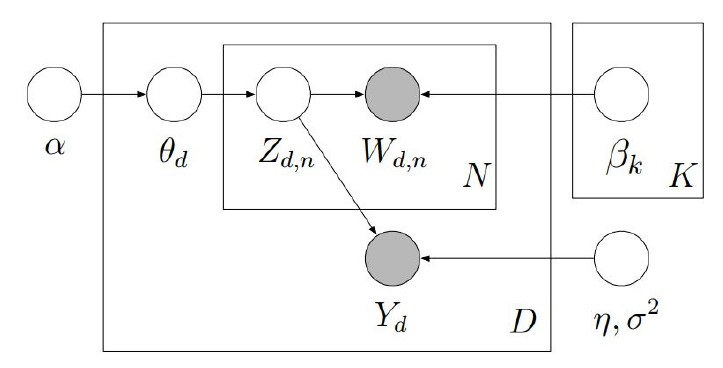
Figure 1. Plate diagram of Supervised Latent Dirichlet allocation